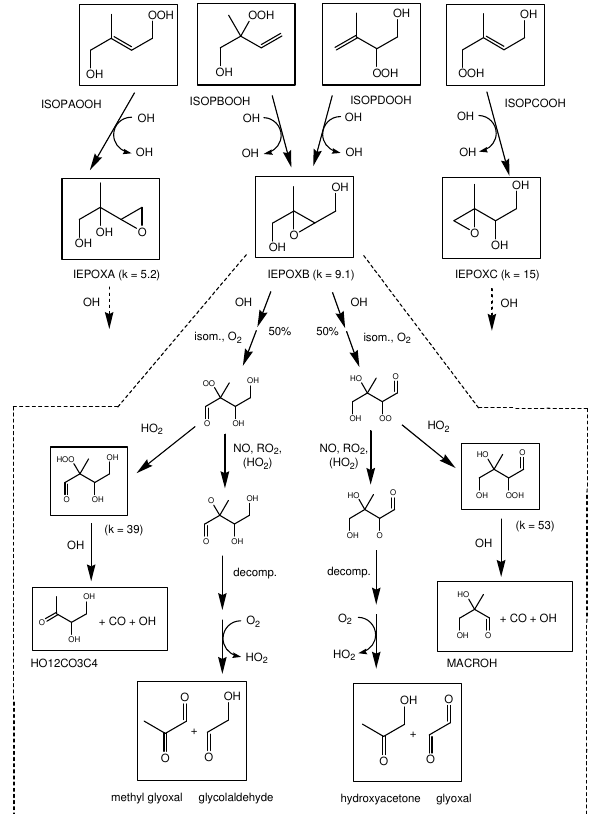
Figure 5. Schematic representation of the revised OH initiated degradation chemistry of the isoprene-derived hydroperoxides and epoxydiols in Mechanisms 2a and 2b. The chemistry is based on the mechanism of Paulot et al. (2009a), involving initial OH catalysed conversion into epoxydiols (IEPOXA, IEPOXB and IEPOXC). The main features of the further degradation are shown for the major isomer, IEPOXB. Initiation rate coefficients in units 10 - 12 cm 3 molecule -1 s -1 . Propagating channels for the reactions of HO 2 with the β -oxo peroxy radicals in this mechanistic extension were only represented in the consolidated Mechanism